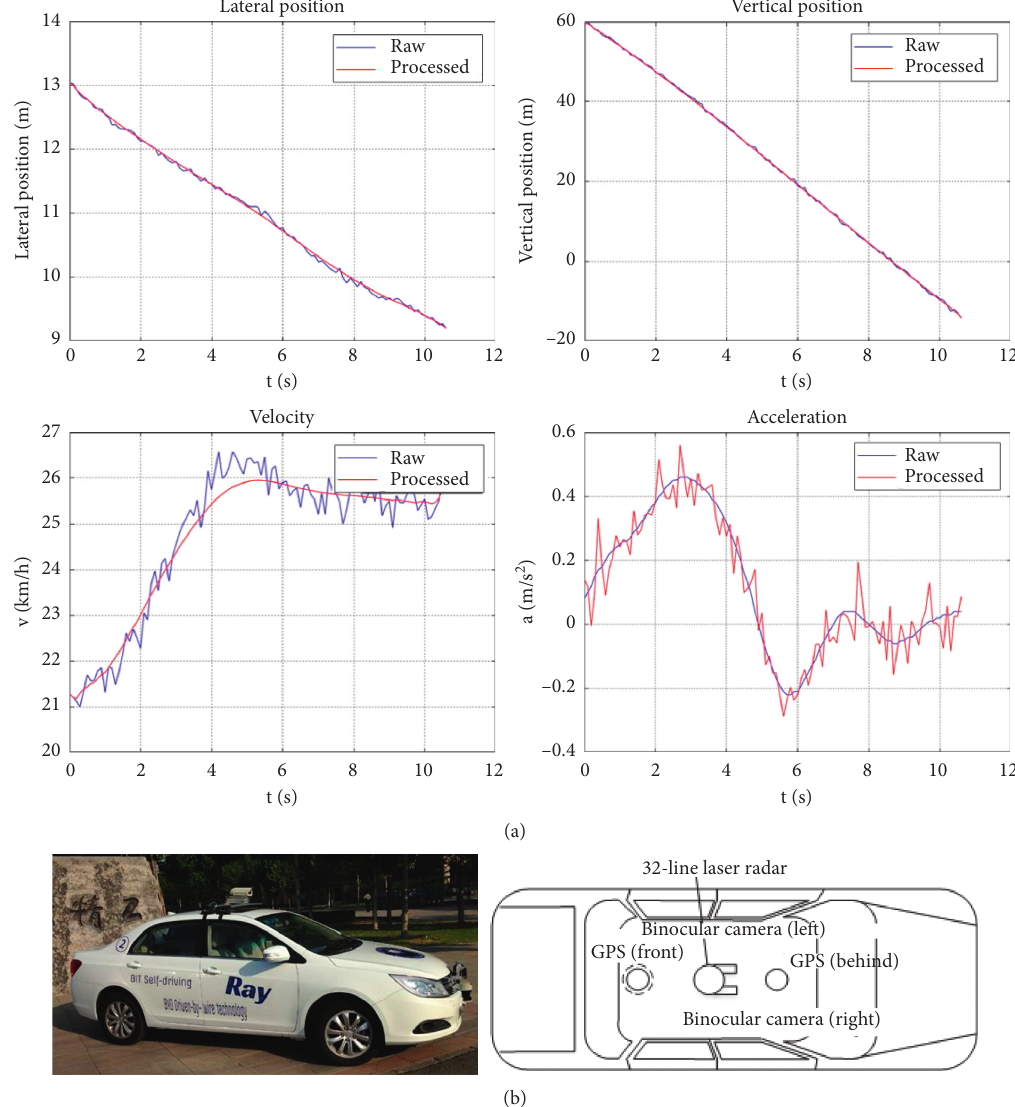
Figure 2: (a) The raw and processed data. (b) The layout of sensors on the BYD retrofit vehicle.